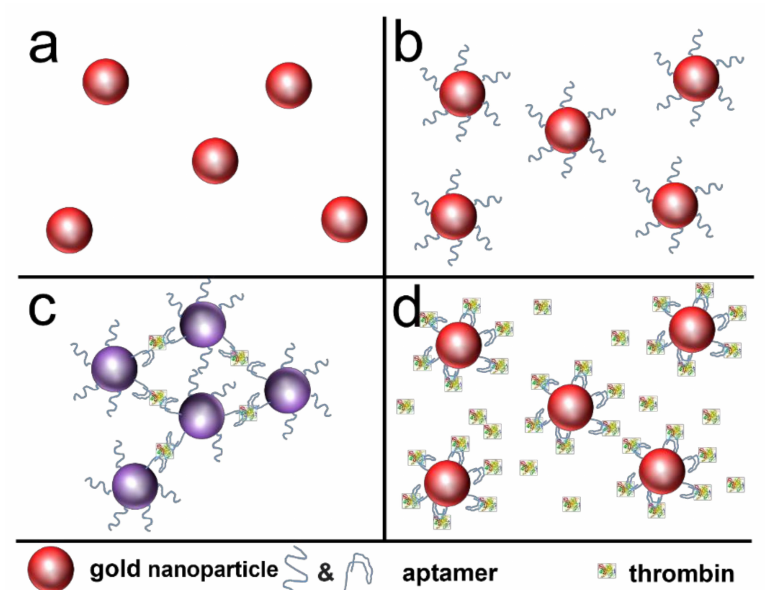
Figure 10. Schematic representation of the detection mechanism of thrombin by AuNPs modified by DNA aptamers: ( a ) monodispersed AuNPs and ( b ) AuNPs modified with aptamers. The aggregation of aptamer–AuNPs in the presence of thrombin at: ( c ) lower concentration and ( d ) higher concentra- tion. Aggregation of the Apt–AuNPs occurred at lower concentration of thrombin, but the AuNPs aggregates dispersed at higher concentration. Reprinted with permission from ref. [115]. Copyright 2013,